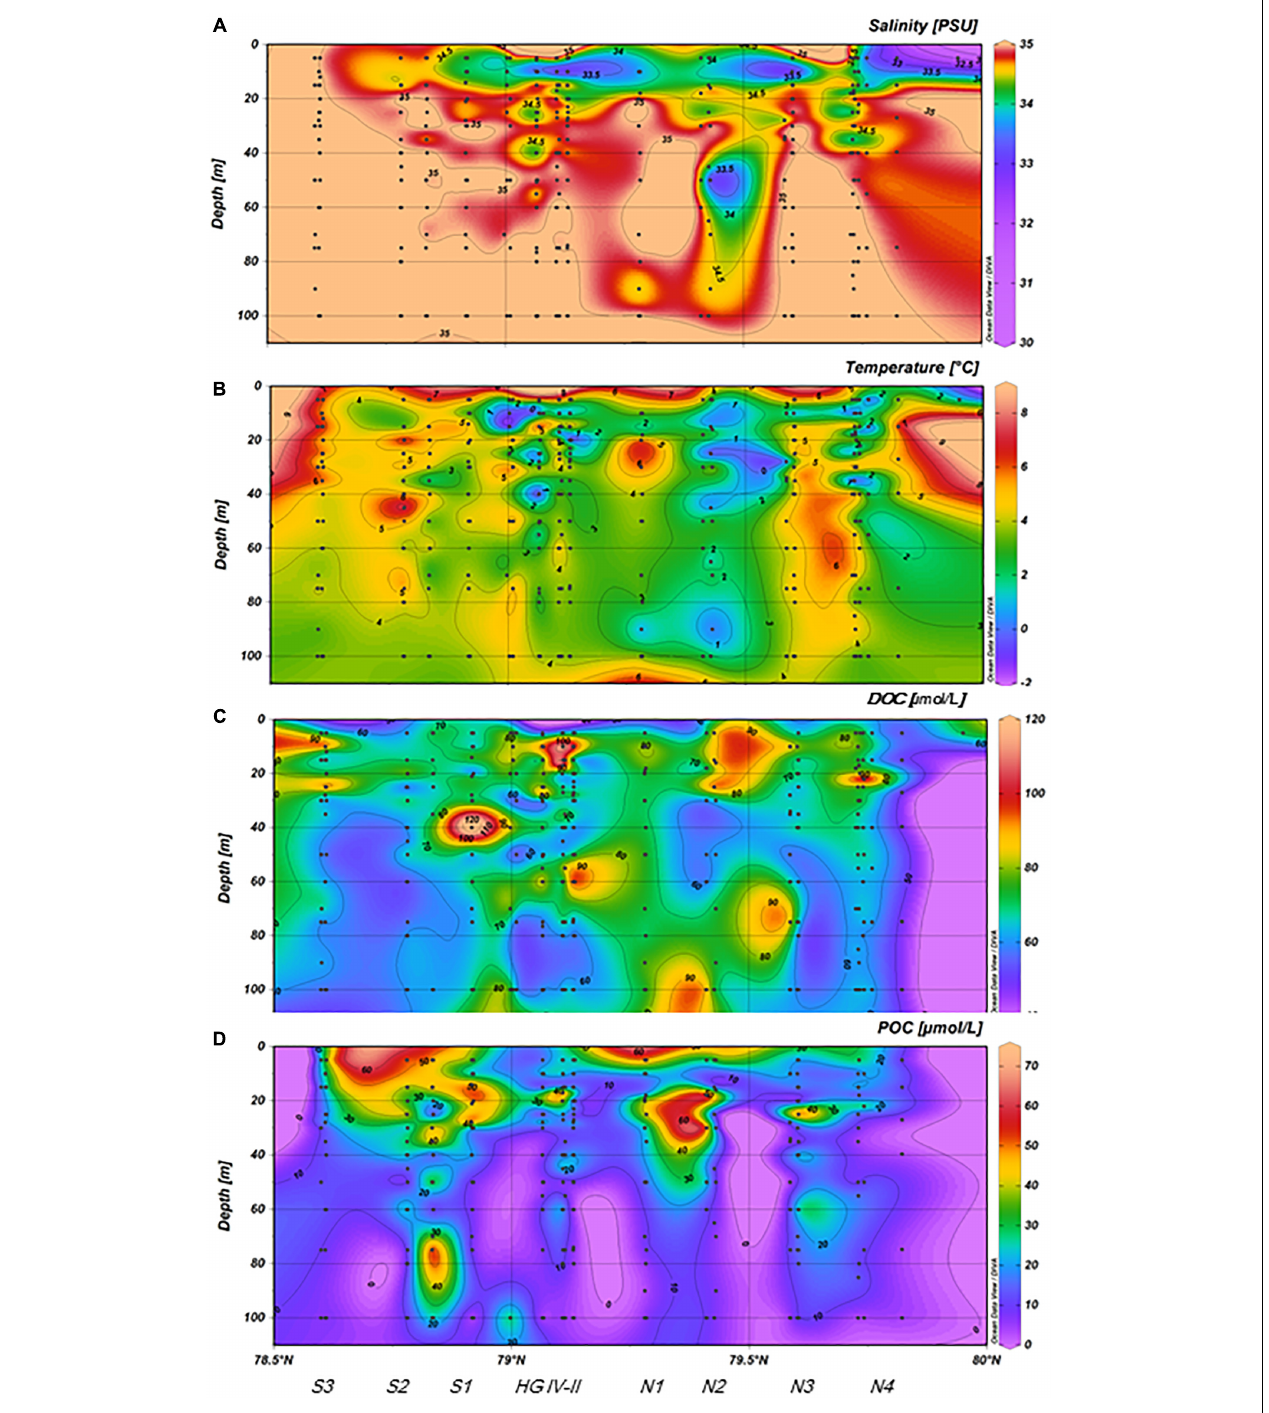
FIGURE 10 | (A–D) Spatial variability of salinity, temperature, DOC, and POC concentration along the ∼ 5 ◦ E longitude during 2009–2017 (merged data).